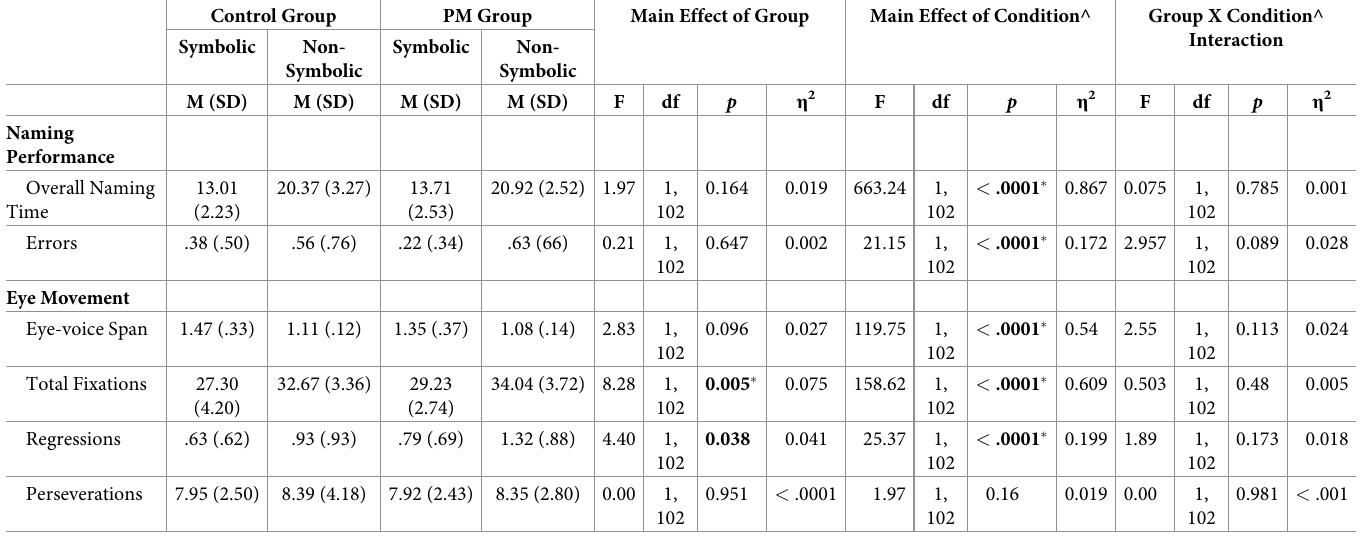
Table 2. Summary of